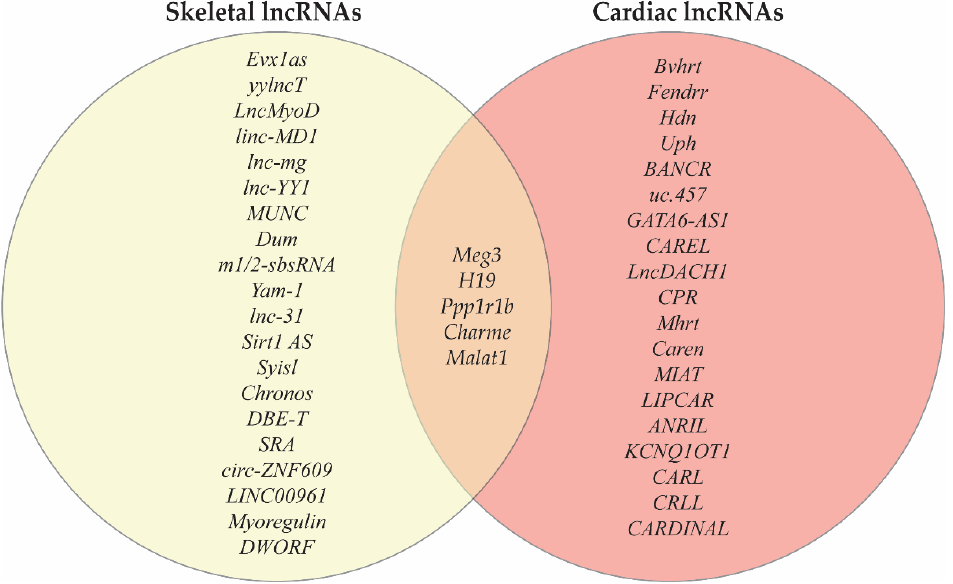
Figure 1. The Venn diagram includes key lncRNAs identified to play an important role in skeletal and/or cardiac muscle. The lncRNAs on the left, inside the yellow circle, are not necessarily only found in skeletal muscle but play an important role in skeletal muscle. The lncRNAs implicated in skeletal muscle development include Evx1as and yylncT. In contrast, the lncRNAs LncMyoD , linc-MD1 , lnc-mg , lnc-YY1 , MUNC , Dum , m½-sbsRNA , Yam-1 , lnc-31 , Sirt1 AS , Syisl , Chronos , and DBE-T , are primarily involved in skeletal muscle regeneration and disease. The skeletal muscle micropeptides include SRA, circ-ZNF609, LINC00961, Myoregulin, and DWORF. Similarly, the lncRNAs on the right, inside the red circle are not all exclusively expressed in cardiac tissue but have been demonstrated to play a role in the heart. The lncRNAs implicated in cardiac development include Bvhrt , Fendrr , Hdn , Uph , BANCR , uc.457 , and GATA6-AS1 ; while the lncRNAs primarily involved in cardiac regeneration and disease are: LncDACH1 , CAREL , MIAT , Mhrt , Caren , LIPCAR , ANRIL , KCNQ1OT1 , CARL , CRP , CRLL , and CARDINAL. Notably, there are a number of lncRNAs that have demonstrated roles in both cardiac and skeletal muscle including Meg3 , H19 , Ppp1r1b , Charme , and